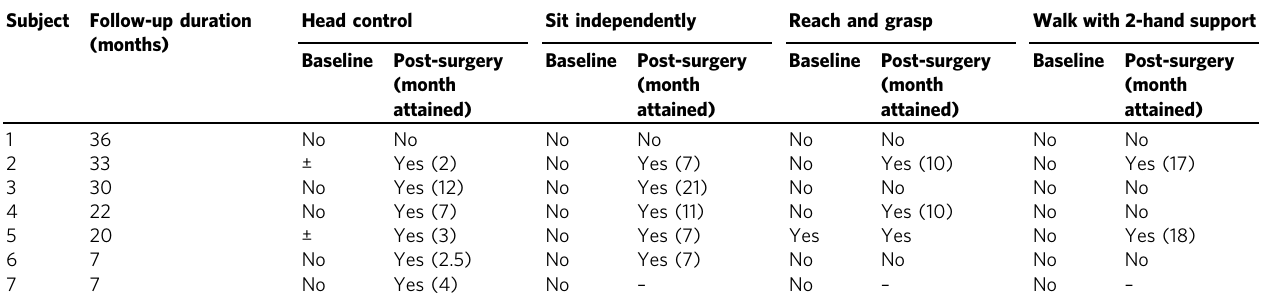
Table 3 Developmental milestones after gene